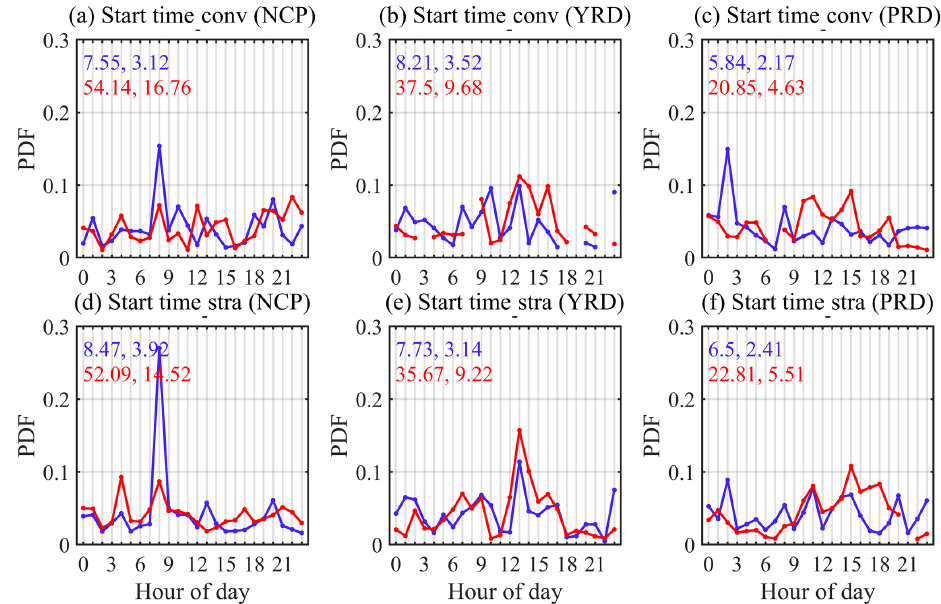
Figure 7. Normalised PDFs of (a) – (c) convective precipitation start time and (d) – (f) stratiform precipitation start time (LT), represented as ratios of their corresponding precipitation frequency at a given hour to those accumulated over 24h under clean (blue lines) and polluted (red lines) conditions in June–August from 2015–2020 over the NCP, YRD, and PRD, respectively. The blue (red) numbers are the average (the first column) and standard deviation (the second column) of the PM 2 . 5 mass concentration (µgm − 3 ) under clean (polluted)